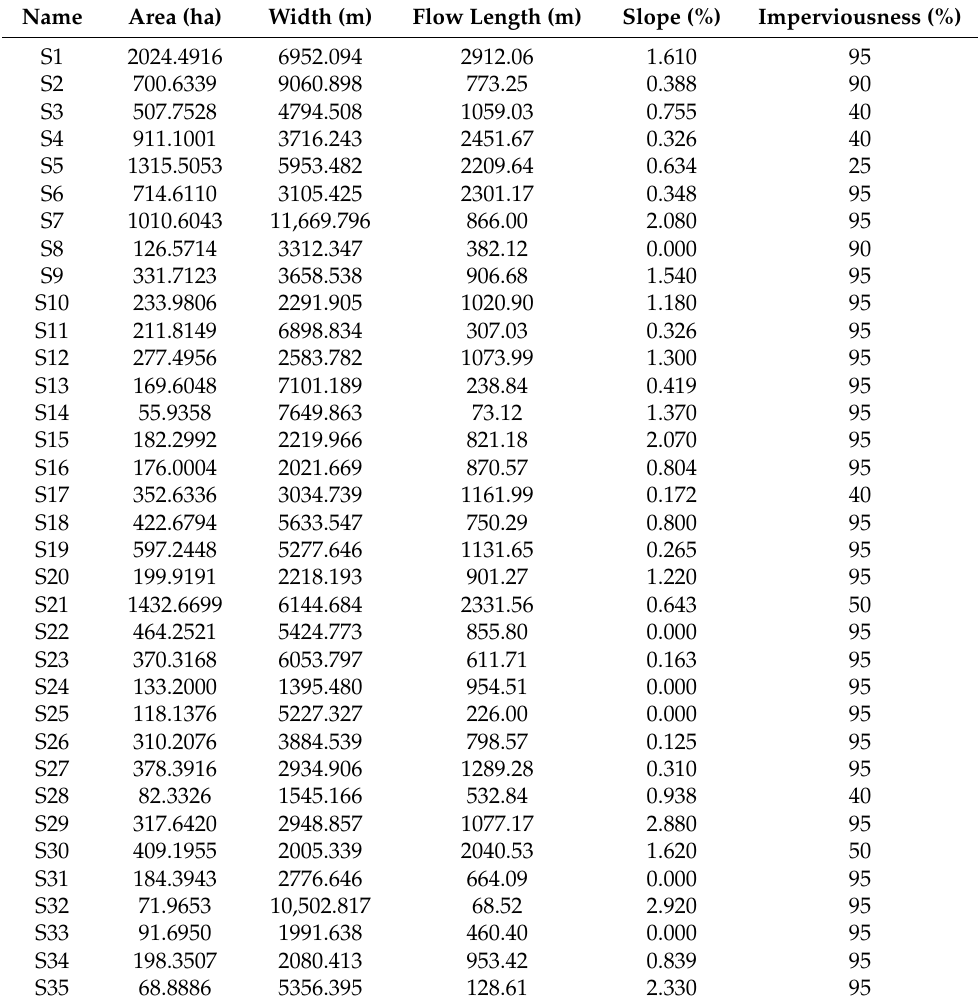
Table A1. Hydrology input parameters for the 1-D river flow model.